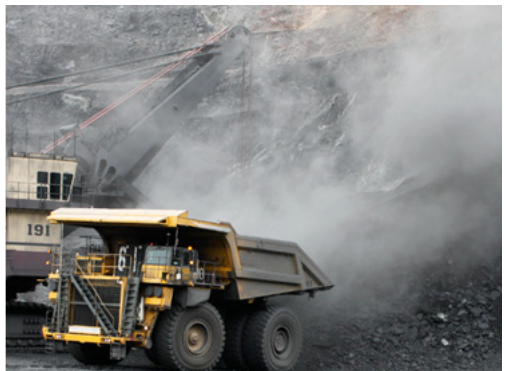
Figure 4: Mining shovel loading a hauling truck